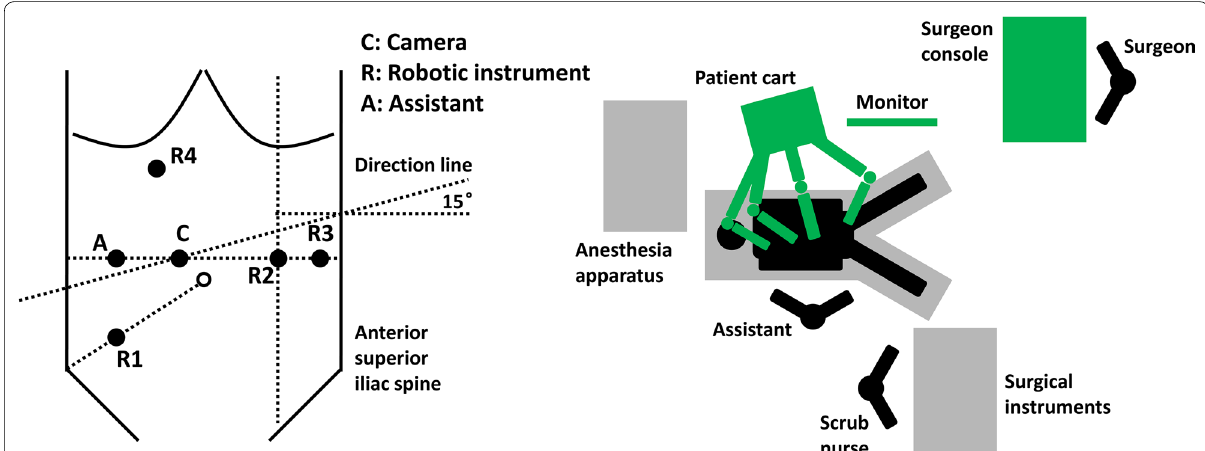
Fig. 2 Trocar location and operating room setup for left colic flexure mobilization in robot-assisted radical resection of rectal or sigmoid